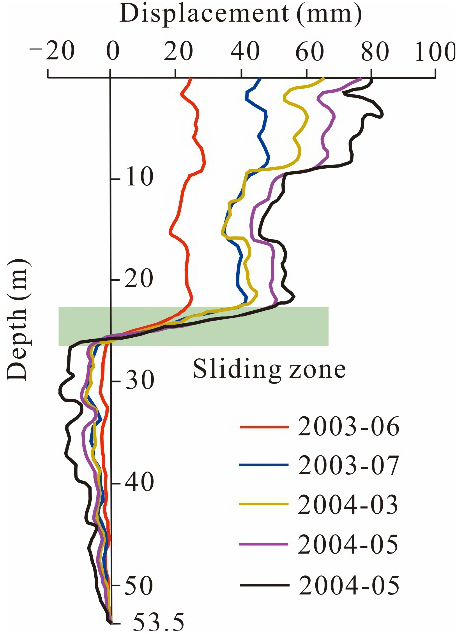
Figure 9. Lateral deformation versus depth in inclinometer D7.